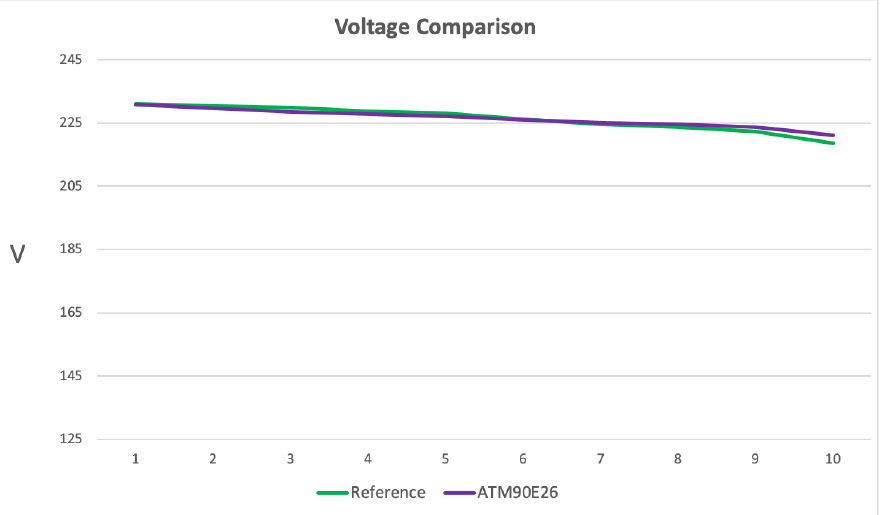
Figure 13. Voltage measurement comparison: Measurements on the vertical axis in Volt, while the horizontal axis expresses the number of measures